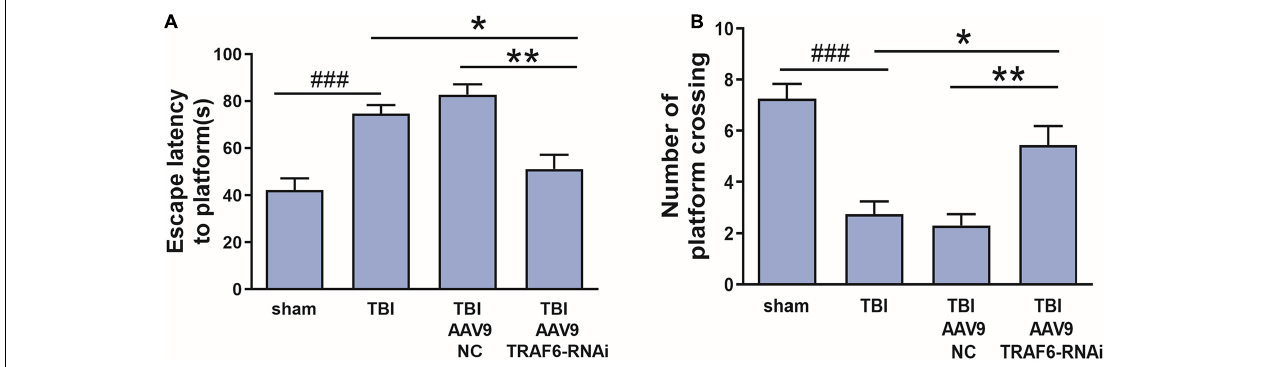
FIGURE 4 | Knockdown of TRAF6 after TBI rescued spatial learning and memory. Sham and TBI model rats receiving intracerebral injection of knockdown vector (AAV9-TRAF6-RNAi) or negative control vector (AAV9-NC) were compared for spatial learning and memory in the Morris water maze at 3 days post-TBI (or sham surgery). (A) Escape latency is presented as mean ± SEM (s). Administration of AAV9-TRAF6-RNAi reduced average latency to the escape platform, indicating improved spatial learning following TBI. * P < 0.05 and ** P < 0.01 vs. AAV9-TRAF6-RNAi group. ### P < 0.001 vs. sham group. (B) The number of platform location crossings is presented as mean ± SEM. Administration of AAV9-TRAF6-RNAi increased the number of platform crossings following TBI, indicating improved spatial memory. * P < 0.05 and ** P < 0.01 vs. AAV9-TRAF6-RNAi group. ### P < 0.001 vs. sham group.